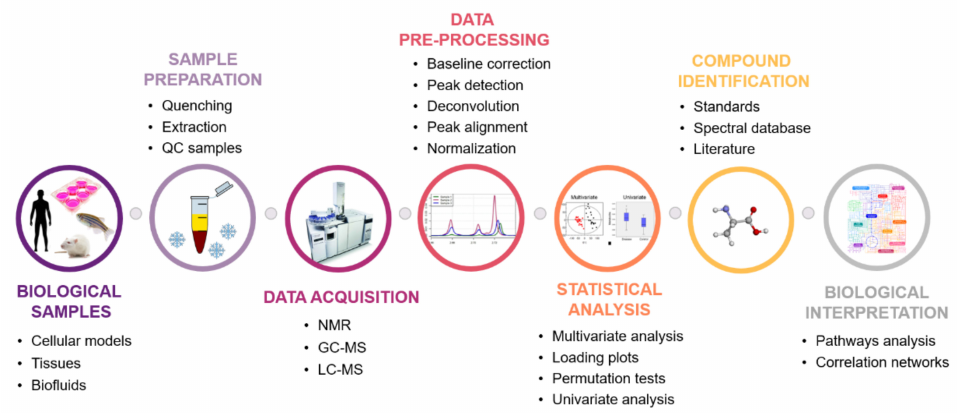
Figure 3. Schematic representation of a general untargeted metabolomics